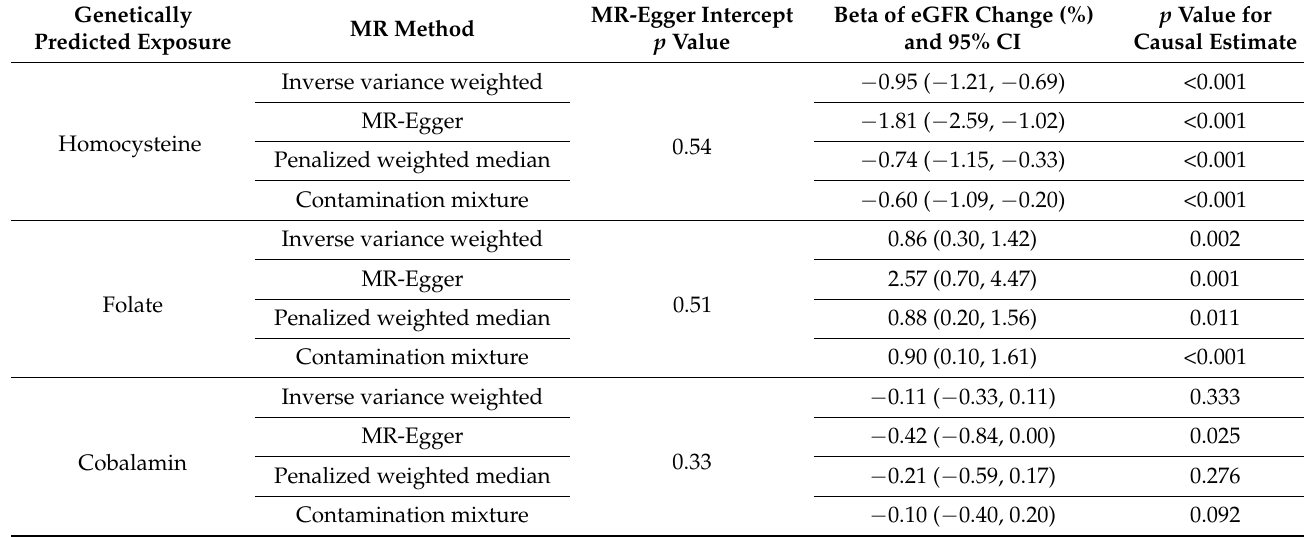
Table 3. Allele-score-based Mendelian randomization results with the U.K. Biobank data.